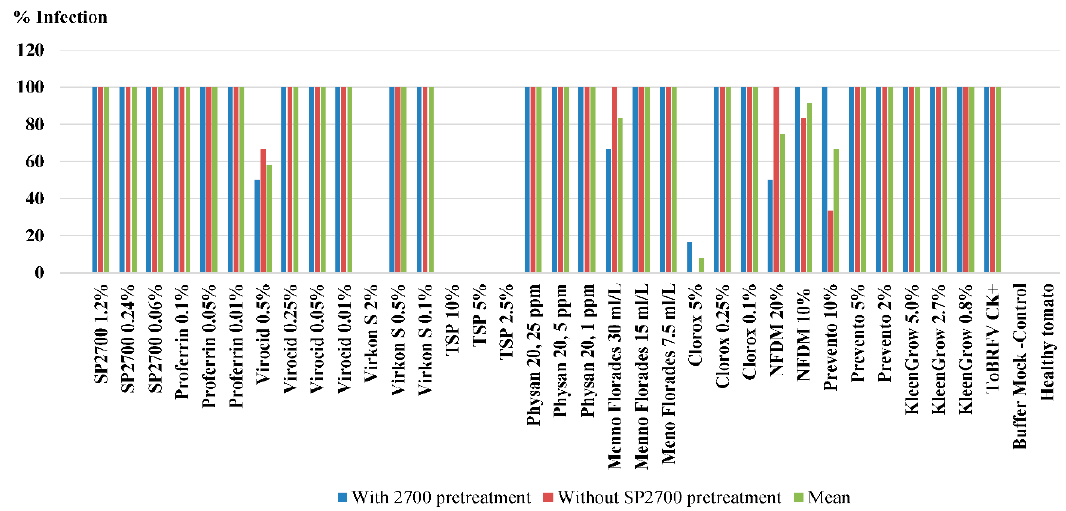
Figure 2. Mean percent infection rates on test tomato plants infected by ToBRFV in two bioassay experiments to assess efficacies of disinfectants at their specified concentrations. In two separate experiments, similar effects in disinfection against ToBRFV infectivity were observed on various disinfectants using test plants that were either pre-treated with SP2700 or without pre-treatment. The positive control (ToBRFV CK+) showed 100% infection, whereas the Mock treatment with buffer as well as tomato plants without inoculation remained healthy. TSP: trisodium phosphate, NFDM: nonfat dry milk.